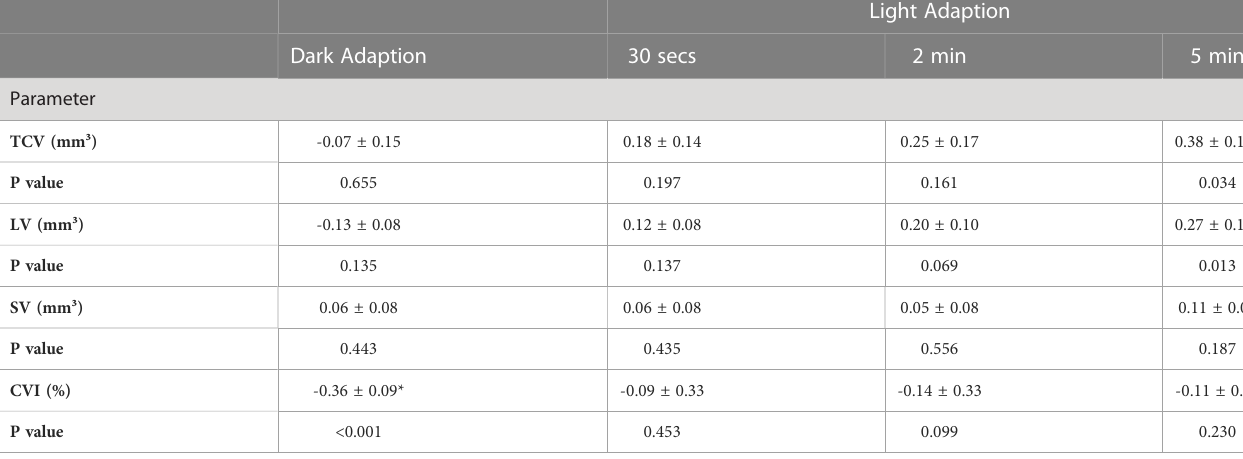
TABLE 2 Mean differences in choroidal parameters change between glucose and control conditions during light modulation.